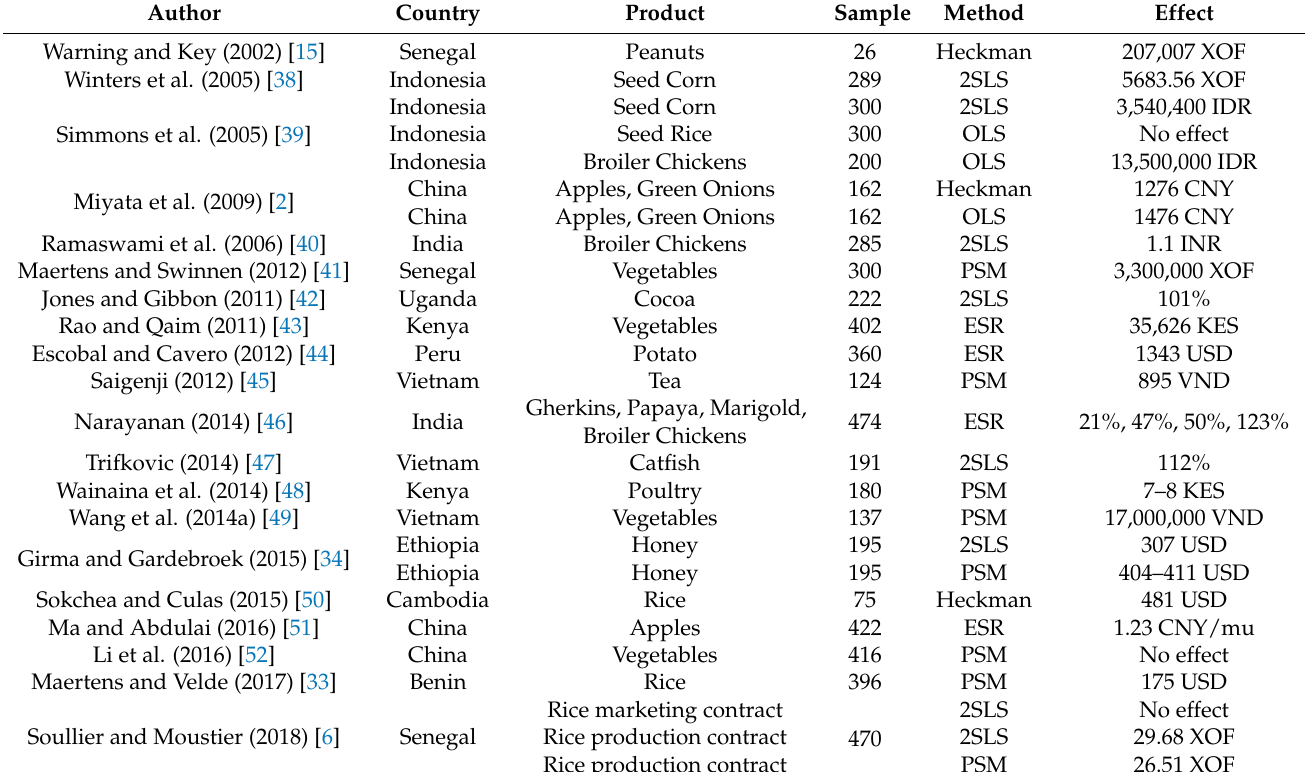
Table 1. Literature review in the impact of contract farming on